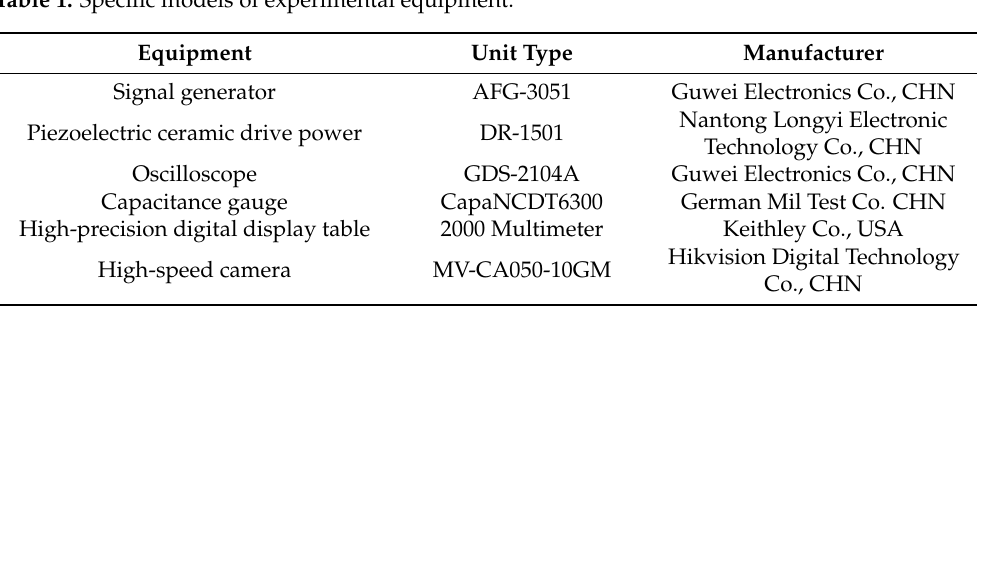
Table 1. Specific models of experimental